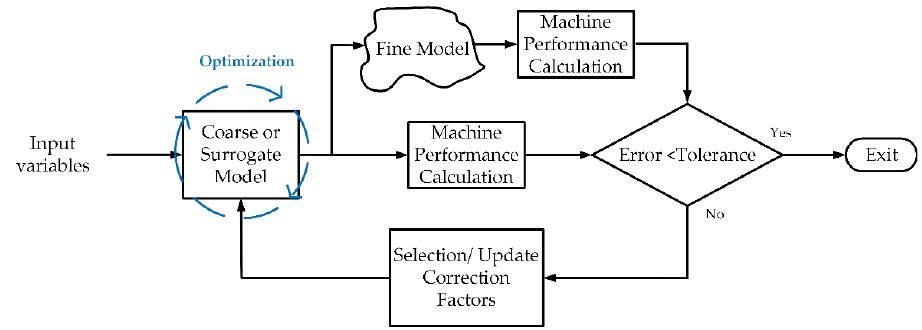
Figure 4. Flowchart to illustrate the SM concept.